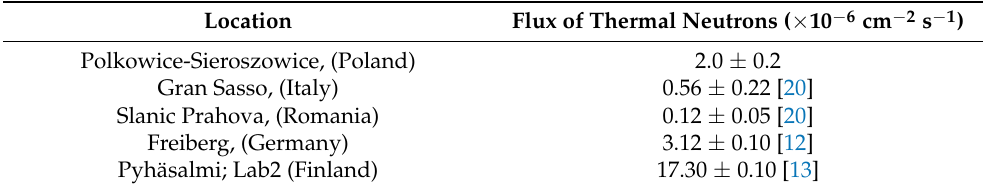
Table 5. Comparison of thermal neutron flux measurement in different European underground